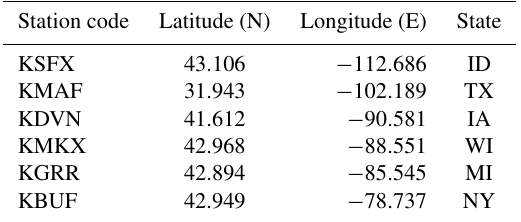
Table 1. The station code and locations of the six NWS dual- polarization radars from which data are presented (listed from west to